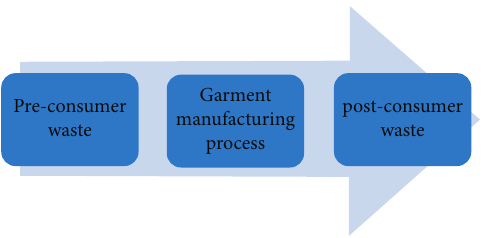
Figure 1: Four categories of food waste: at the postharvest level, during manufacturing, during retail and distribution services, and finally at the household level inspired from [3].